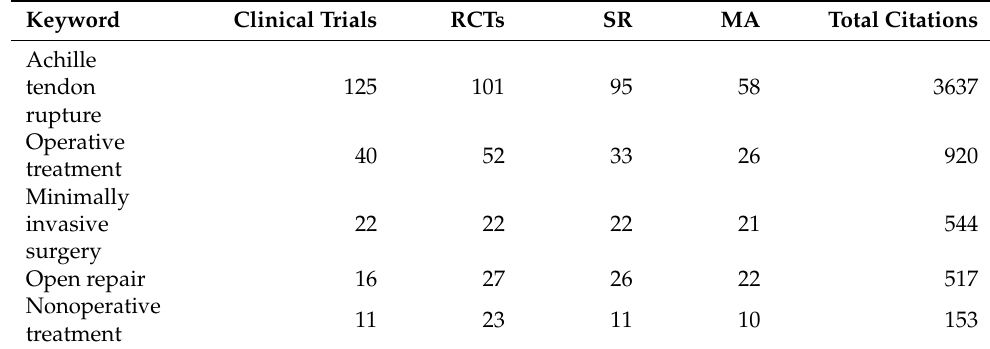
Figure 2. Citations metrics for type of study. Graphic legend: RCT = randomized clinical trials; SR = Table legend: RCT = randomized clinical trials; SR = systematic review; MA = systematic review; MA = metanalysis.